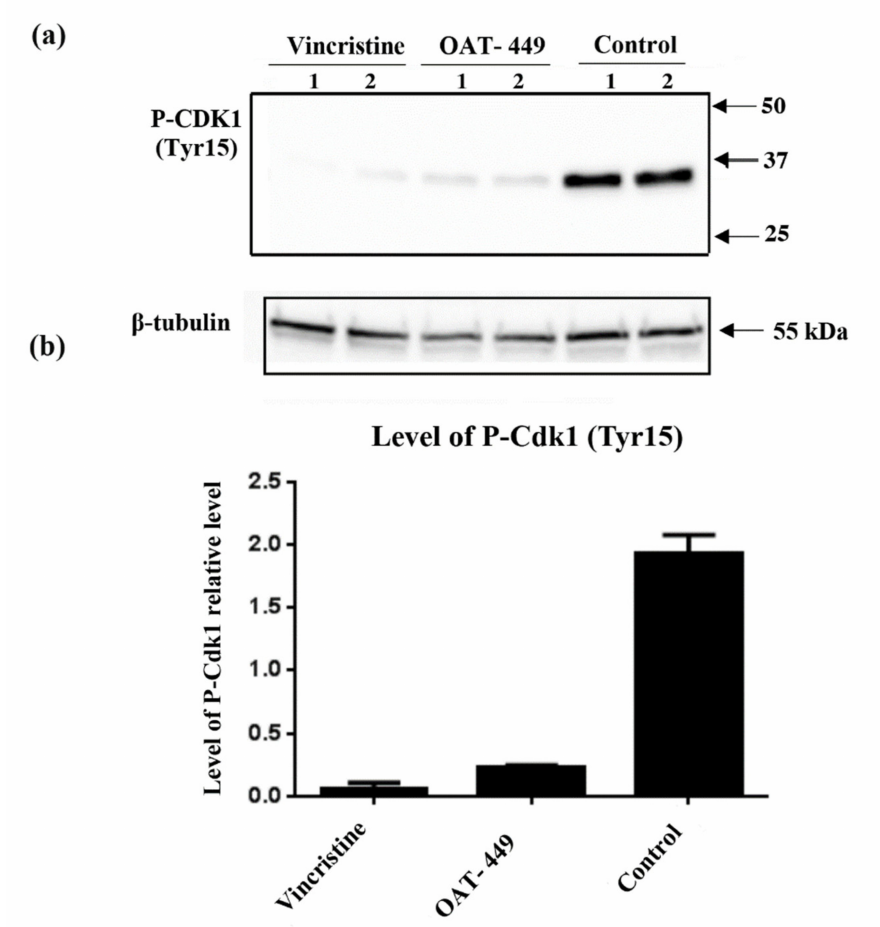
Figure 6. OAT-449 causes a reduction in phosphorylation of Cdk1 immunoblotting of P-Cdk1 (Tyr15) in whole cell lysate of HT-29 in basal condition and upon 18 h treatment with 30 nM OAT-449 or vincristine. ( a ) Immunoblot, showing biological duplicate lanes (1–2) for each condition. ( b ) Densitometry of immunoblot data, with signal intensity relative to β -tubulin (mean ± SEM). Data are representative of 3 independent